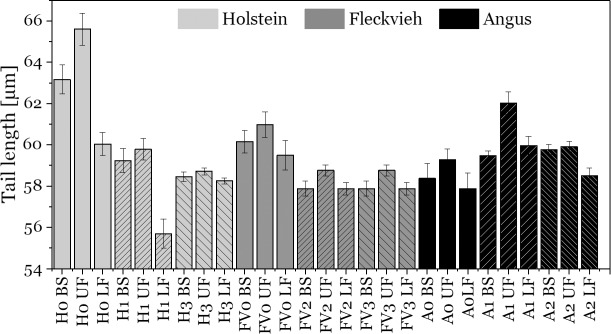
Sperm flagella length of swim-up fractions from 9 bulls of different breeds.100 sperm cells were measured for each bar. Error bars are standard error of the mean. Upper fractions contain consistently longer sperm tails (estimate = 1.05, p = 0.04) compared to the initial sperm sample. The lower fractions contain consistently shorter tails (estimate = -0.98, p = 0.05). BS = before swim-up. UF = upper fraction. LF = lower fraction. H0-3 = Holstein bulls, FV0-3 = Fleckvieh bulls, A0-2 = Angus bulls.